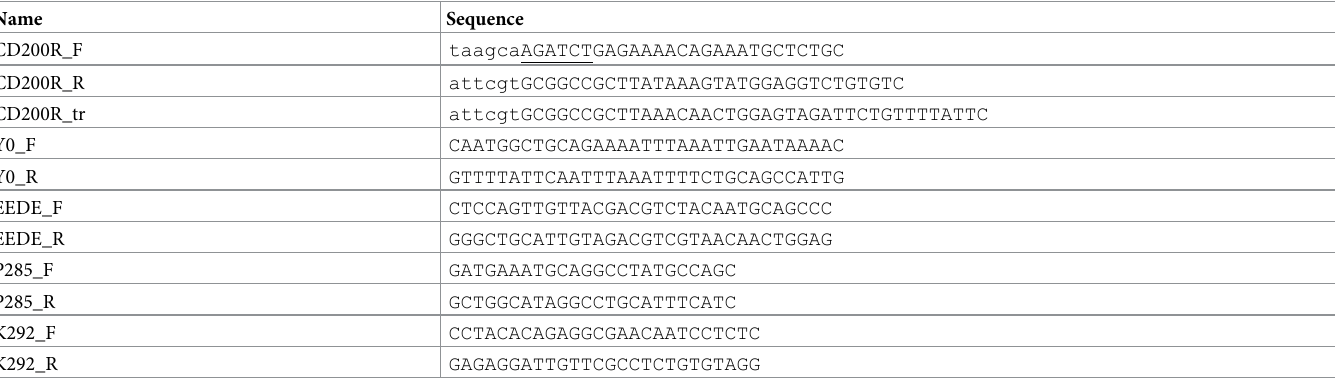
Table 2. Primer sequences for mutagenesis and